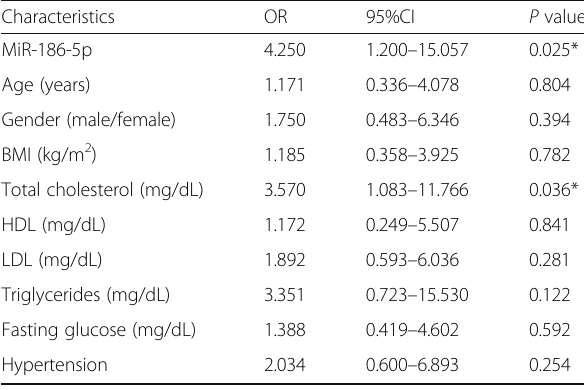
Table 3 Association of different variables with the degree carotid stenosis in patients with asymptomatic CAS